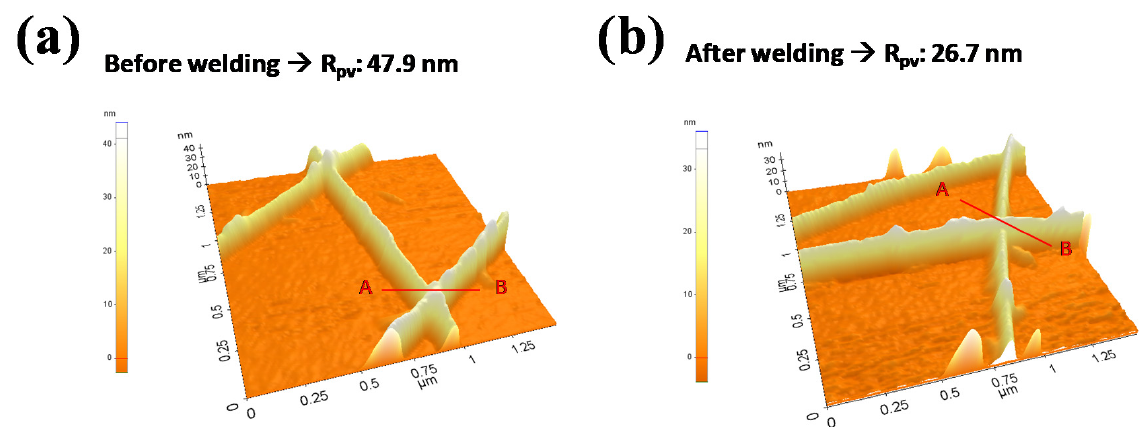
Figure 5. Surface roughness of a single Ag NW junction measured by 2-dimensional AFM. ( a ) before and ( b ) after welding at the 800 kHz frequency with the condition shown in Figure 4d.